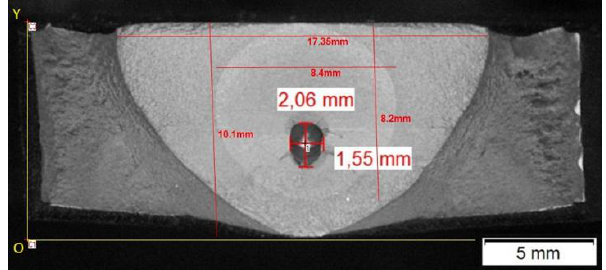
√ area > 1000 µ m [30].